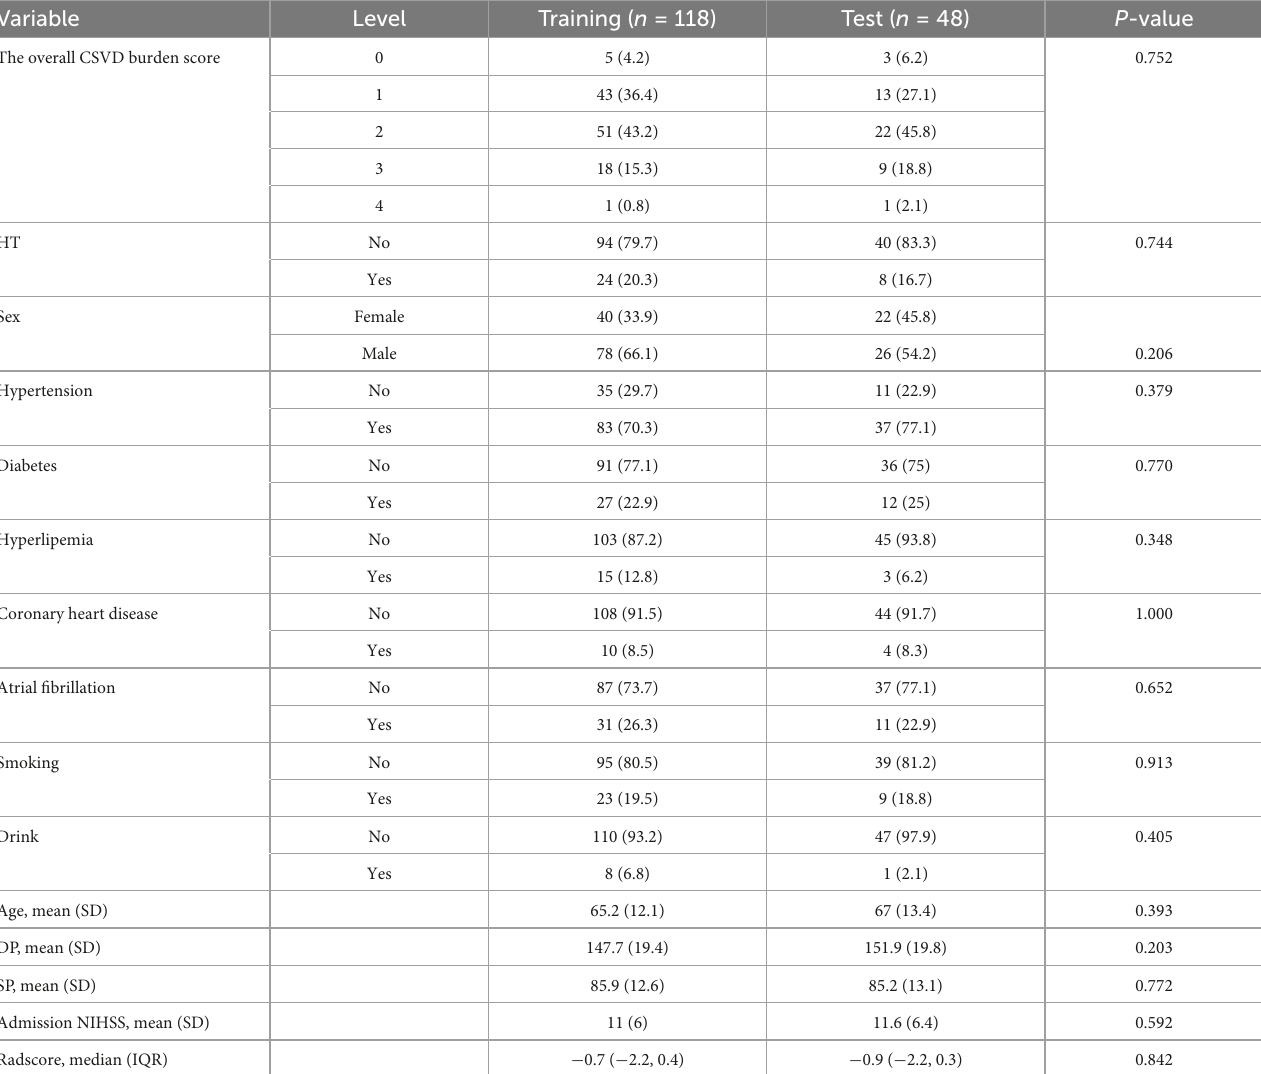
TABLE 2 Population characteristics of patients with AIS in the training and test sets. Variable Level Training ( n = 118) Test ( n = 48) P -value The overall CSVD burden